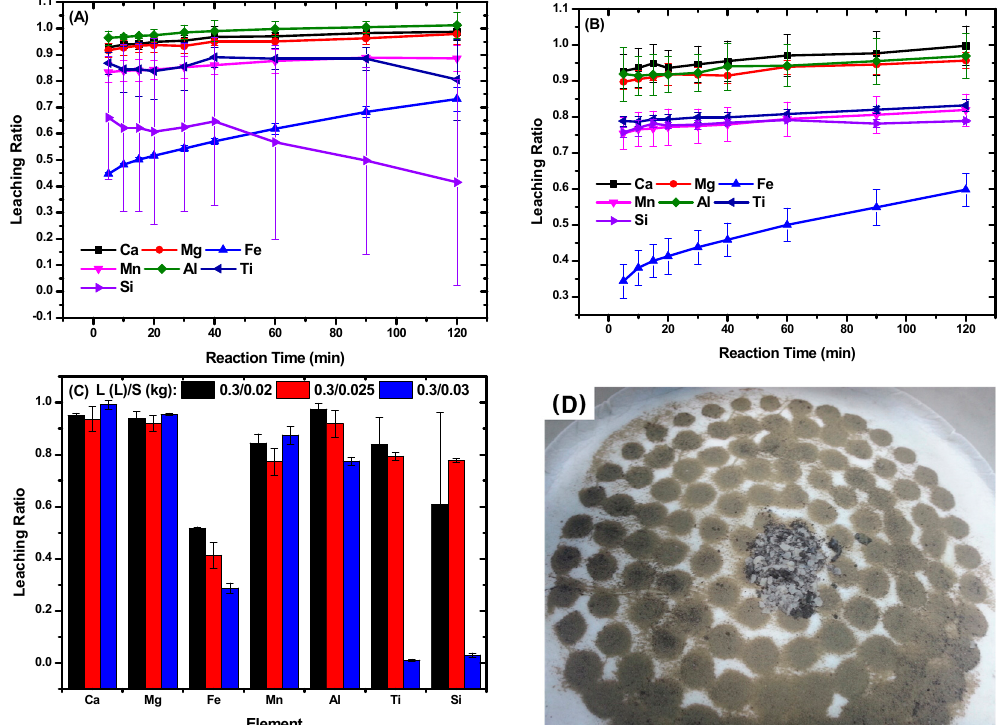
Figure 4. Effects of the variation in the weight of BFS of ( A ) 20 and ( B ) 25 g in a 20% AR solution (300 mL) on the leaching ratio (LCH. R) of elements. Graph ( C ) denotes the comparison of the leached ratio of elements corresponding to the ratio of slag weight (g) to AR (20%) liquid volume (mL) of 20/300, 25/300, and 30/300 at a leaching time of 20 min. Picture ( D ) represents the residue washed with DI water upon filtration after a leaching time of 120 min with 25 g slag/300 mL at 20%